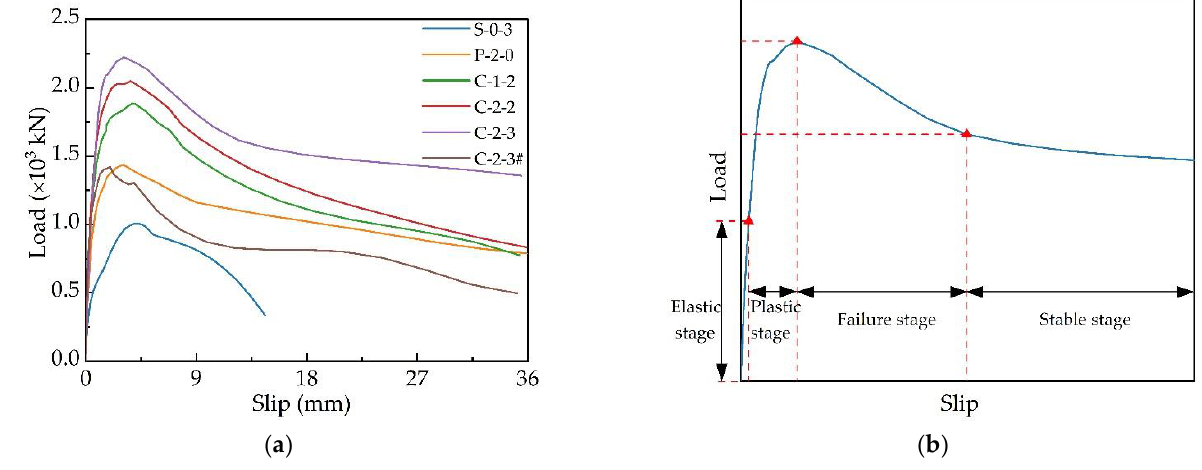
Figure 9. Load – slip curves of specimens: ( a ) experiment curves; ( b ) typical curve of composite connectors.